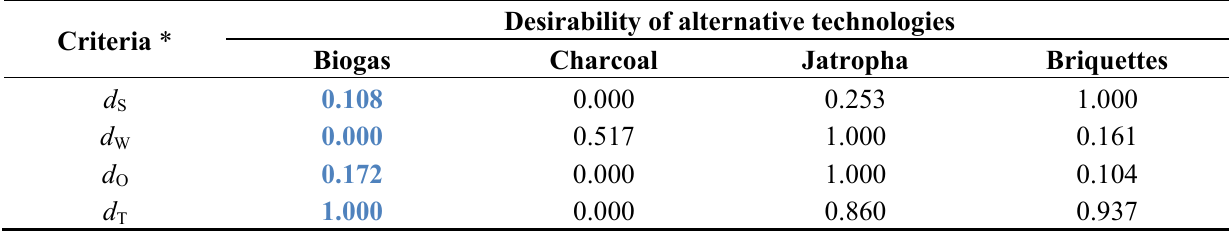
Table A3. Desirability values of the criteria of each